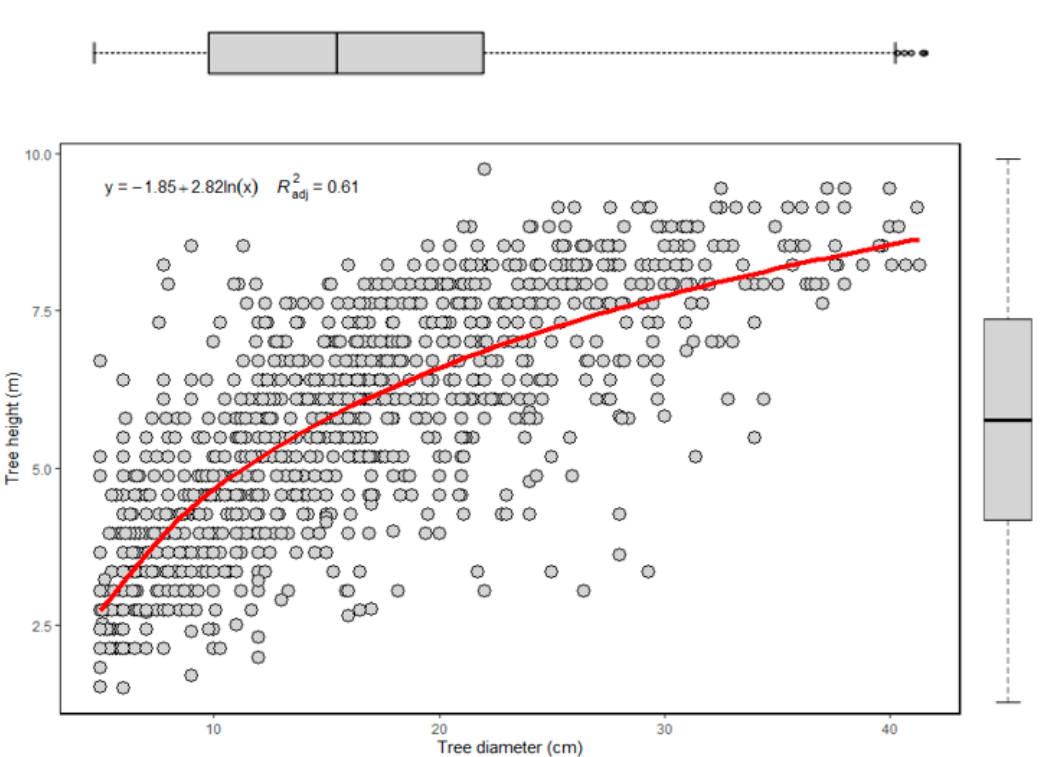
Figure 4. Scatter plot of tree height vs diameter in the mangrove stand of LetKhutKon Village.